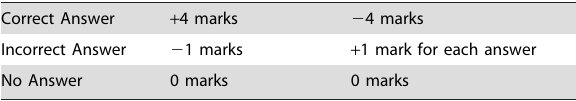
Table 2. Scoring grid for SA and ET MCQ tests with negative marking.